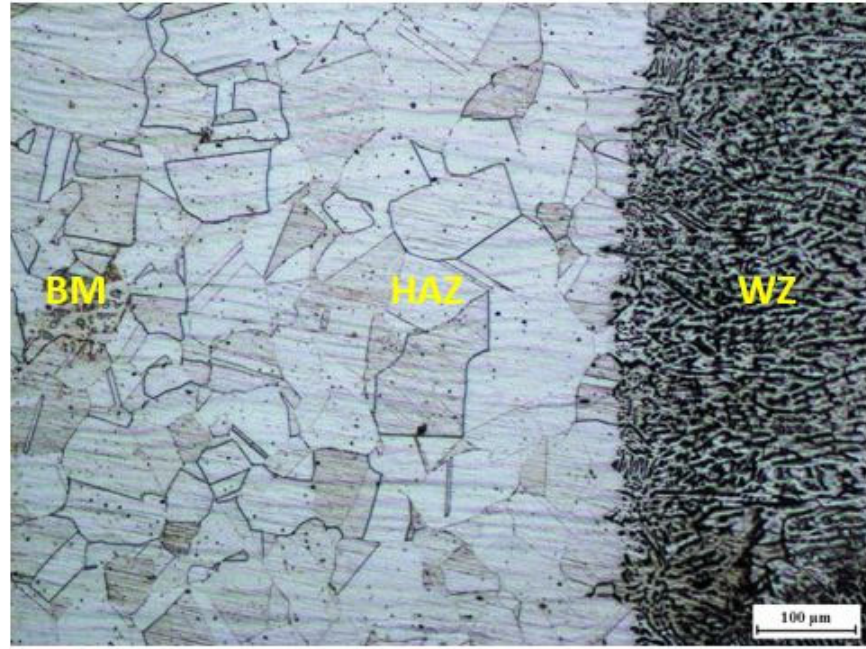
Figure 15. Optical micrograph of 304 austenitic stainless ‐ steel weldment.